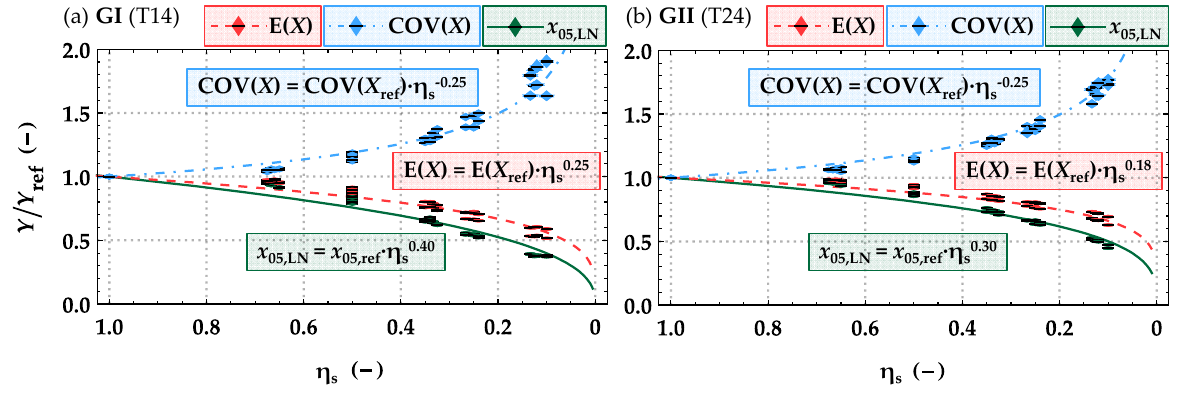
Figure 13. Influence of lengthwise splitting on the main statistics Y = {E( X ); COV( X ); x 05,LN } of the tensile strength parallel to the grain of boards ( X = f t,0,b ) relative to the statistics of full cross-section properties; analysis based on virtually generated boards for GI ( a ) and GII ( b ).